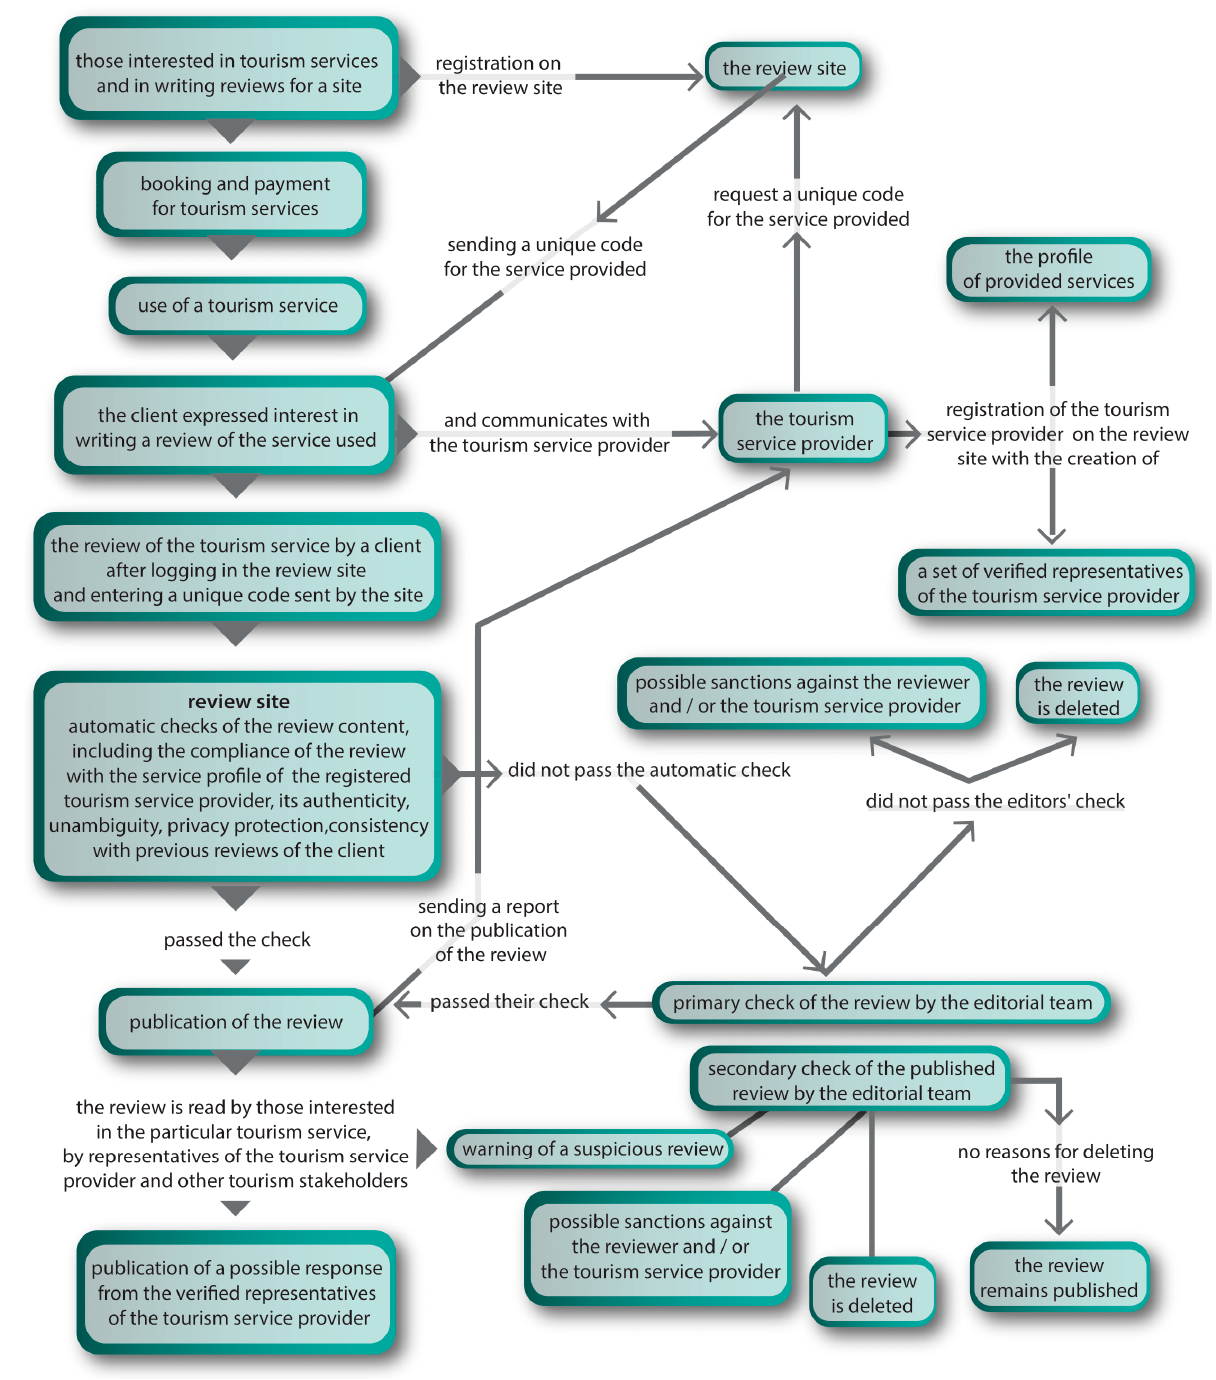
Figure 5. Process model of providing a verified review of tourism services.